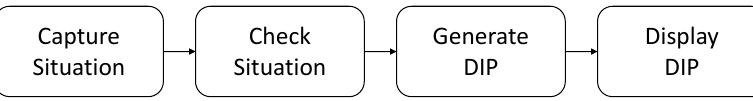
Figure 9. Functionality of